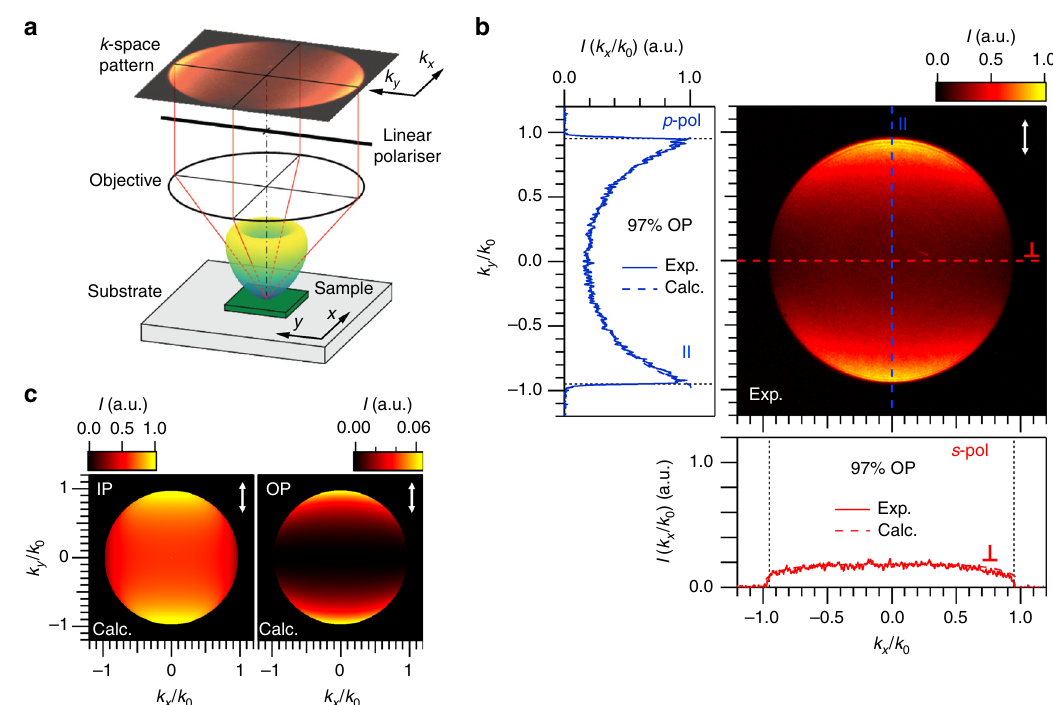
Fig. 1 Orientation of luminescent excitons in bulk InSe. a Sketch summarising the basic concept of the k -space spectroscopy. b Intensity-normalised k -space emission pattern of a 90-nm-thick InSe fl ake deposited on top of a SiO 2 /Si substrate with a SiO 2 thickness of 105.3 ± 0.1 nm as a function of the in- plane (IP) photon wavevector normalised to that in air. The orientation of the transmission axis of the linear polariser used during the experiment is indicated by the white arrow in the top right corner. Blue and red solid lines in the left and bottom panel show the experimental k -space cross-sections measured along the directions || and ⊥ to the polariser (blue and red dashed lines in the charge-coupled device (CCD) image, respectively). The blue and red dashed lines in the adjacent panels represent fi ttings of the experimental data to the analytical model described in Methods, while the vertical black dashed lines represent the largest radiation wavevector collected by the NA of the objective. c Normalised k -space emission patterns calculated for pure IP (left panel) and pure out-of-plane (OP) (right panel) distributions of dipoles, respectively, emitting at an energy of ~1.244 eV (see Fig. 2a) and distributed all along the thickness of a 90-nm-thick InSe fl ake deposited on top of a SiO 2 /Si substrate with a SiO 2 thickness of 105.3